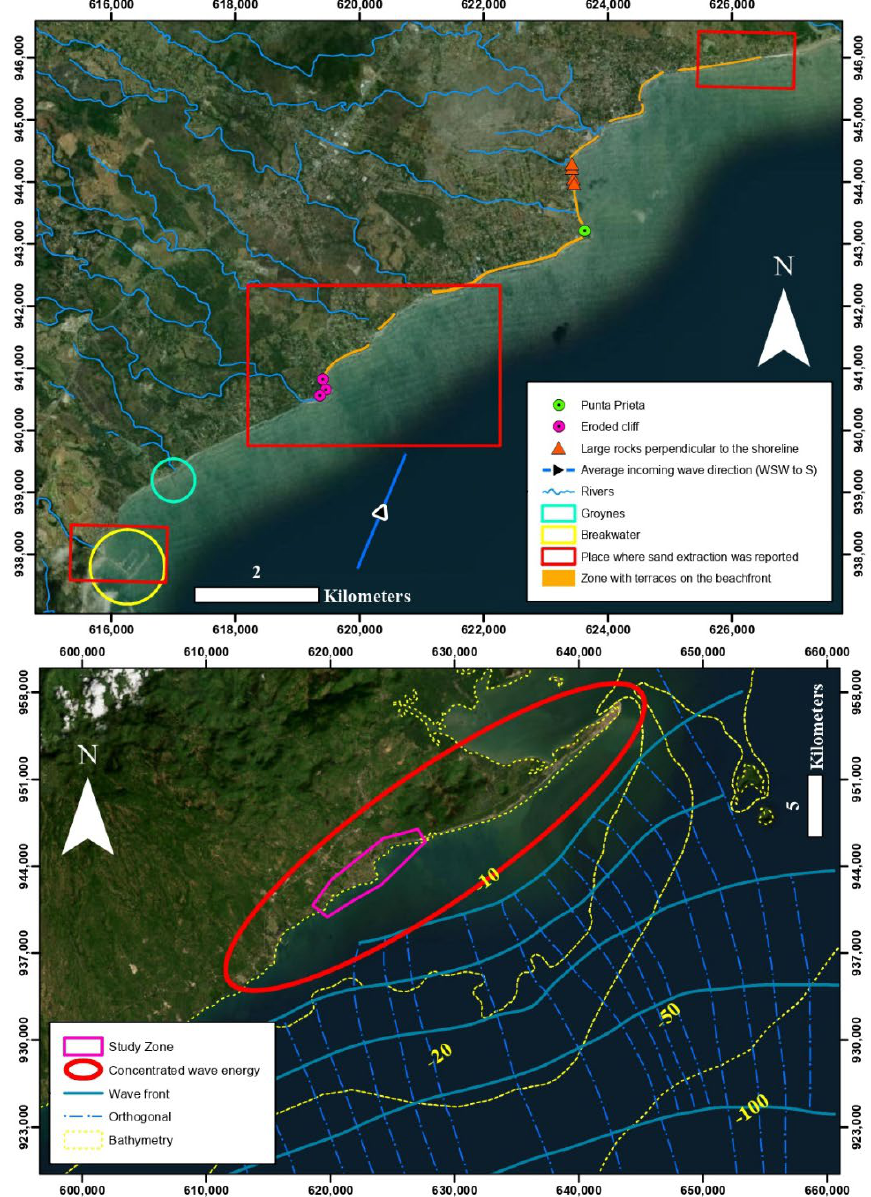
Figure 18. Upper image: factors with possible influence on shoreline change. Lower image: waves map adapted from Grimaldo (2014).